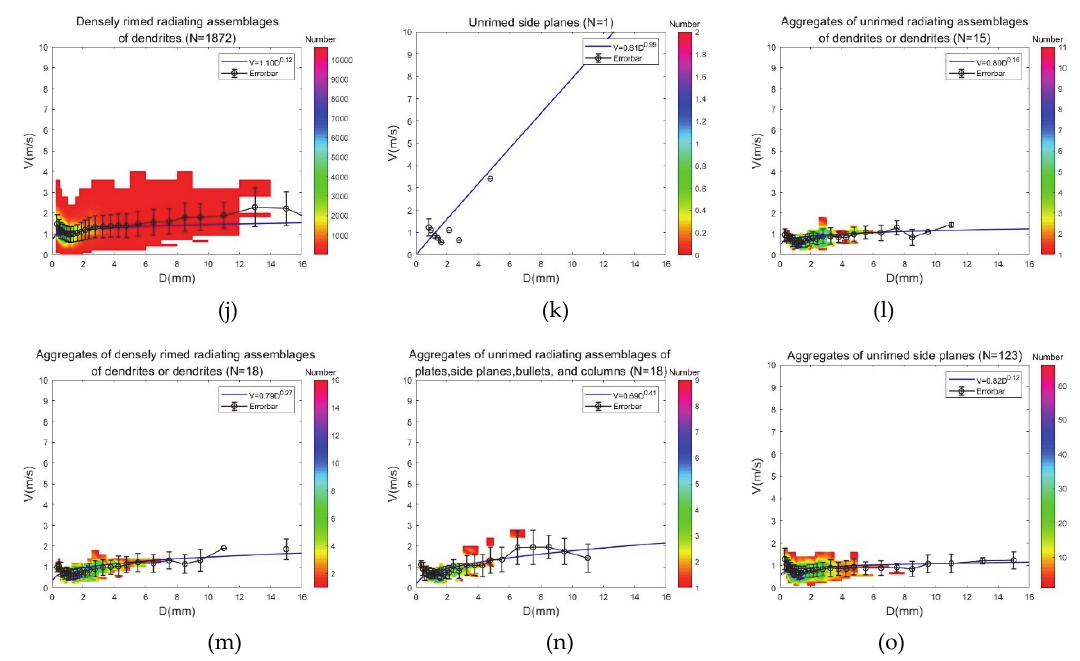
Figure 2. Accumulated raw particle counts by size and velocity for 15 precipitation types and their corresponding V – D empirical relationship (blue lines) from Locatelli and Hobbs [36] and Atlas et al. [38].